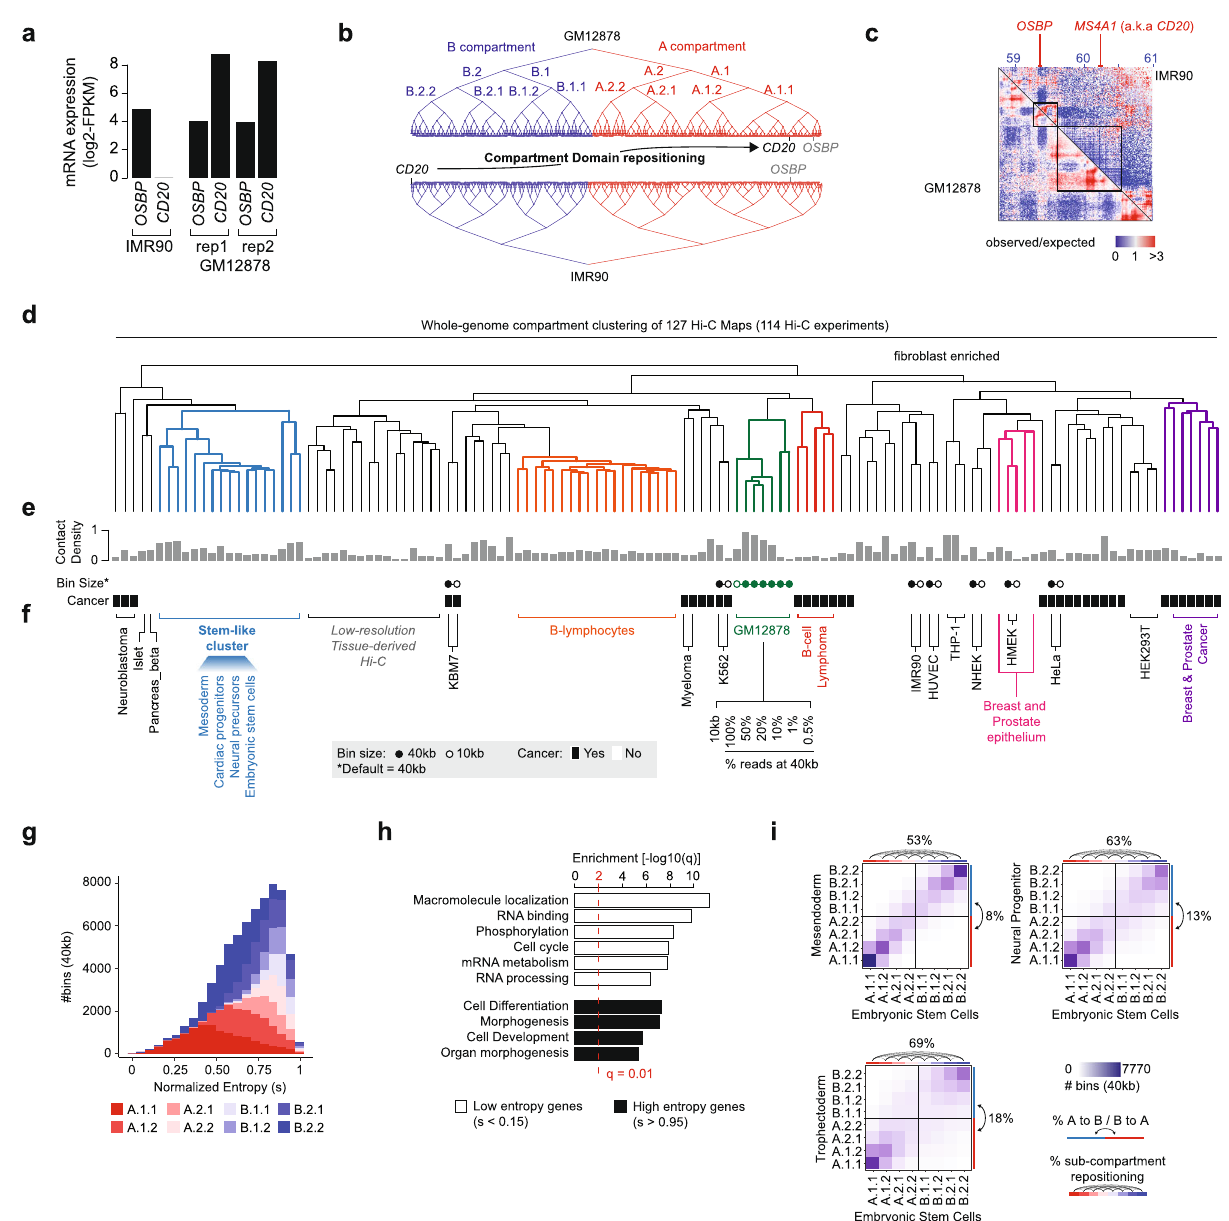
Fig. 3 Subcompartments and compartment domain repositioning analysis across 114 cell lines. a mRNA expression levels (RNA-seq, log-transformed FPKM) of OSBP and CD20 (gene name: MS4A1 ) in the IMR90 cell line and two replicates of the GM12878. b Chromatin domain hierarchy built by Calder for chromosome 11 in IMR90 (bottom) and GM12878 (top). TADs containing OSBP and CD20 and the 8 subcompartments are indicated in the hierarchy. The CD20 domain is repositioned from B.2.2 to A.1.1 compartment (arrow). c Observed/expected (O/E) contact map of GM12878 (lower triangle) and IMR90 (upper triangle) at Chr.11:58,700 – 61,000 kb. The OSBP and MS4A1 gene loci are indicated in red. d – f Clustering of 127 Hi-C maps based on the subcompartment annotation of each bin (8-compartment model). Hi-C maps are annotated with their contact density (histogram), bin size for maps analyzed at different bin sizes, and based on whether they were derived from a healthy or cancerous tissue (black boxes) ( e ). Representative clusters and cell lines are highlighted ( f ). g Compartment entropy distribution of genomic bins colored by their compartment annotation. h Gene ontology enrichment [-log10(q-value)] for genes in low (S < 0.15) and high (S > 0.95) entropy bins. i Comparison of the number of bins assigned to each compartment (color coded) between H1 embryonic stem cells ( X -axis) and H1 lineage differentiation in mesendoderm (left), neural progenitors (center), and trophectoderm comprising cardiac and neural progenitor and embryonic stem resolution clustered based on their lineage, we cannot exclude the cells (Fig. 3f — blue cluster), as well as two separate clusters possibility that our results were here affected by low read counts comprising normal epithelial and cancer cells (e.g., breast and and/or other technical issues. Previous approaches used the fi rst prostate normal and cancer cell lines — Fig. 3f — pink and purple principal component of the contact enrichment correlation clusters, respectively). A lineage-independent cluster was found matrix (PC1) either to rank genomics bins within a chromosome for a set of low data resolution Hi-C experiments generated from (based on the values of PC1) or to determine A and B tissue specimen (Fig. 3f). Even though other Hi-C maps at similar compartments (based on the sign of PC1). Clustering of the